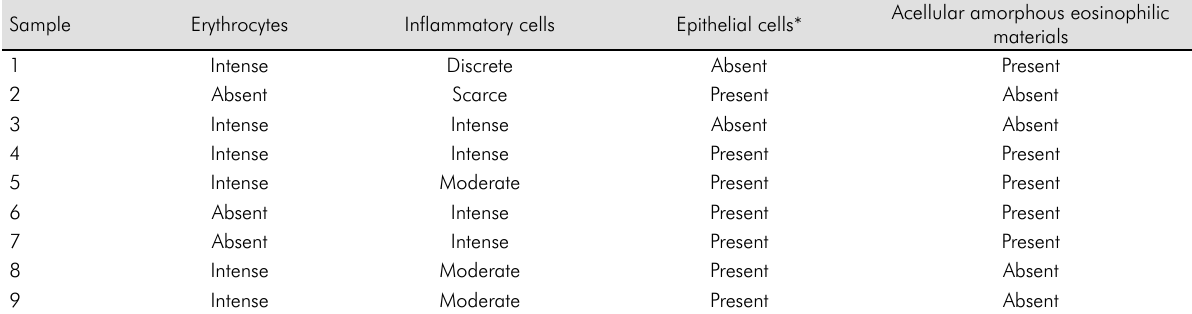
Table 2. Cytological analysis